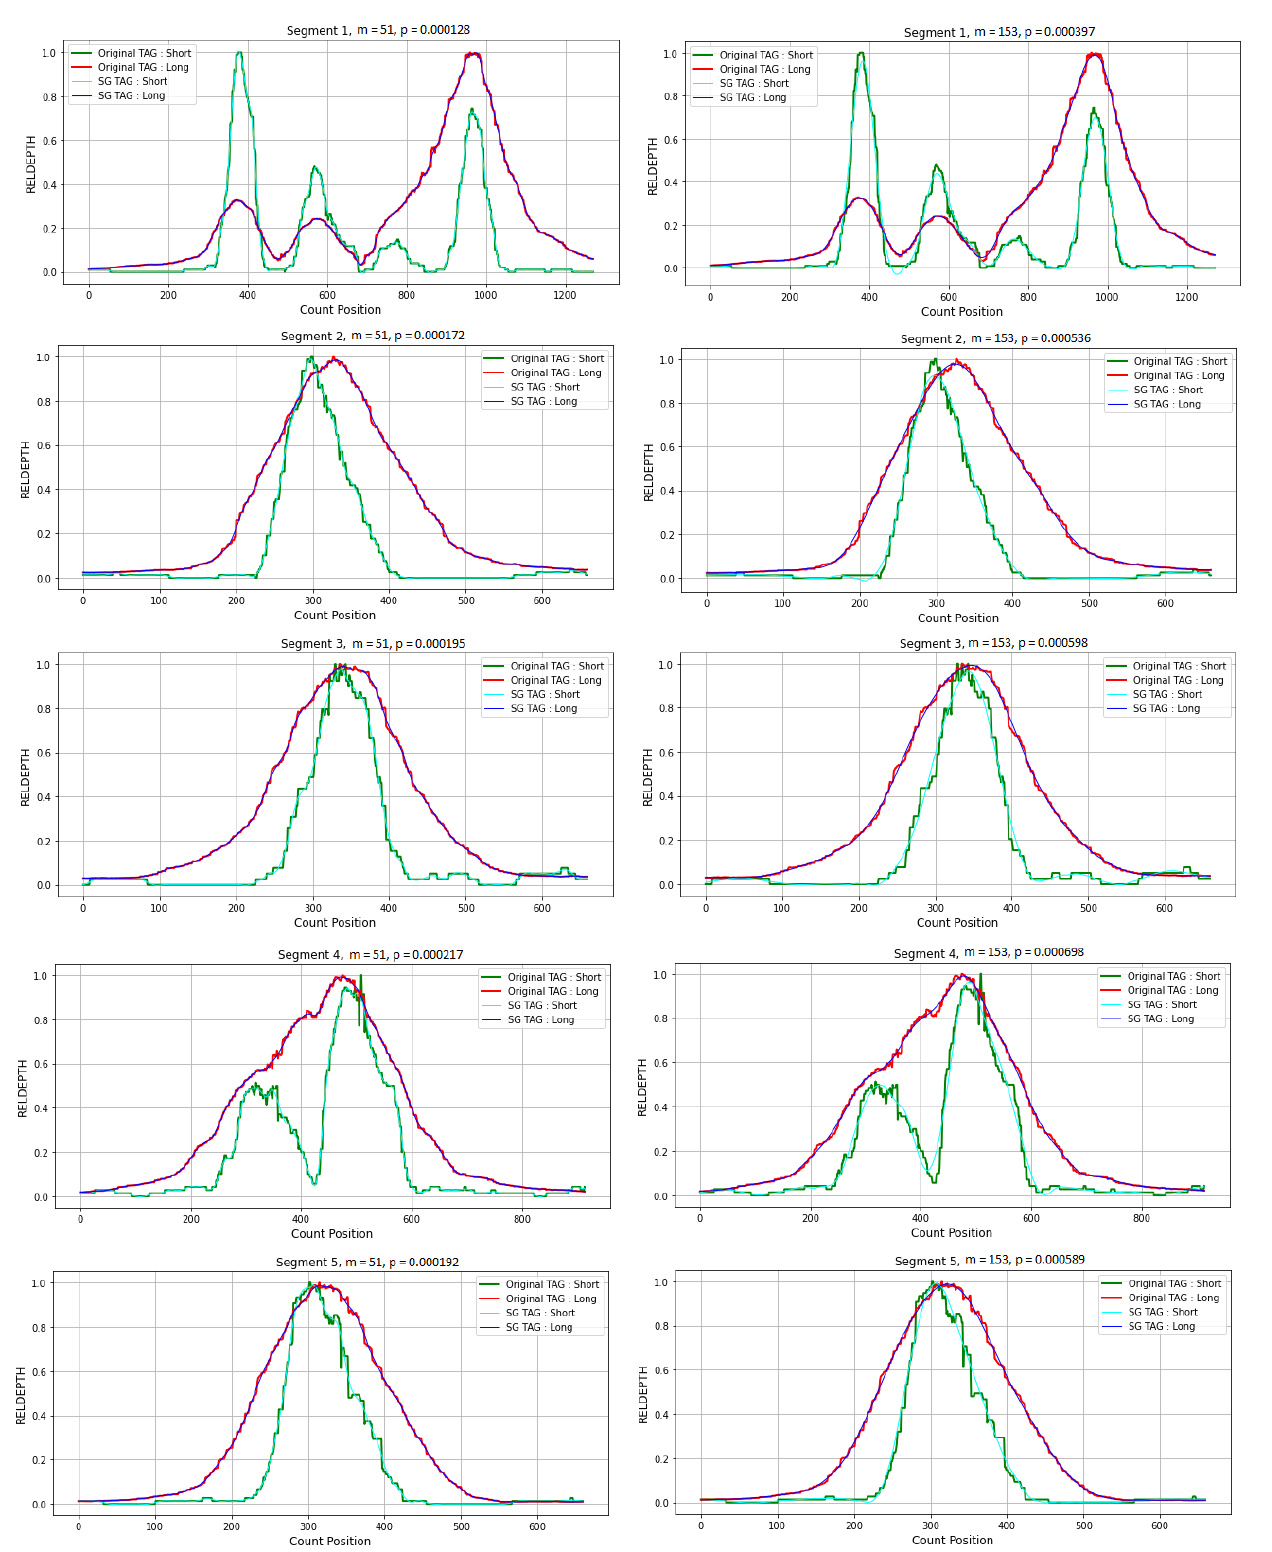
Figure A2. Show Adaptive Savitzky–Golay filtering of CNV peaks for segment 1 to 5 before and after correction. Green and red solid line are the original short and long tag CNV peaks , respectively; cyan and blue solid lines are the smoothed the short and long tags CNV peaks,